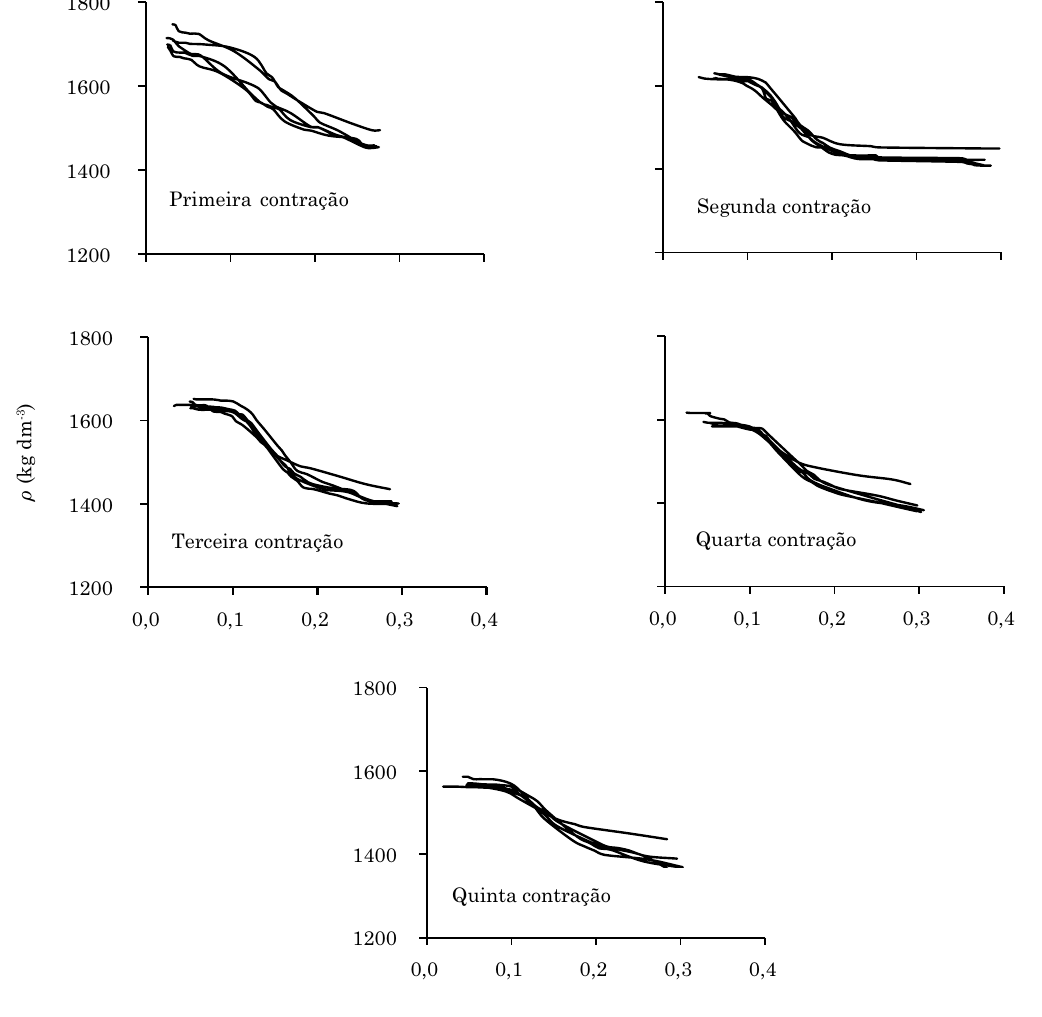
Figura 2. Relação da densidade do solo (ρ) com o conteúdo gravimétrico de água ( U ) nos cinco eventos de contração. Cada curva representa um cilindro de